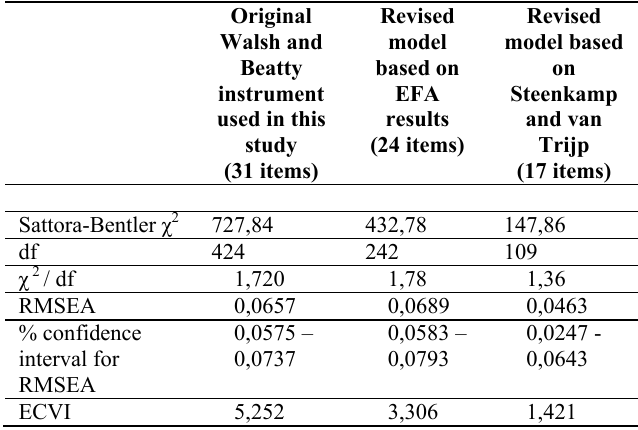
Table 3: Fit indices: cross validation